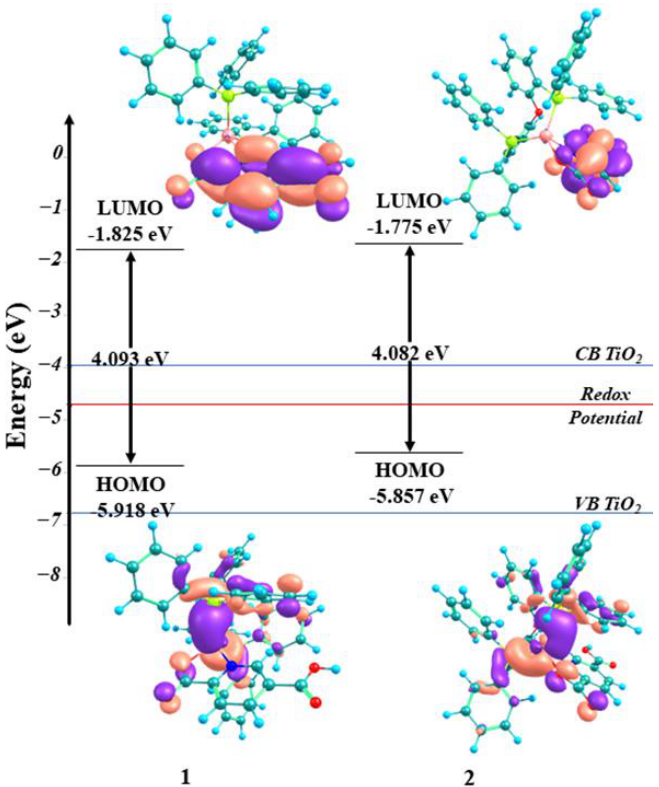
Figure 4. Plots of the molecular orbitals involved in the lowest-lying electronic absorption transitions in complexes 1 and 2 .